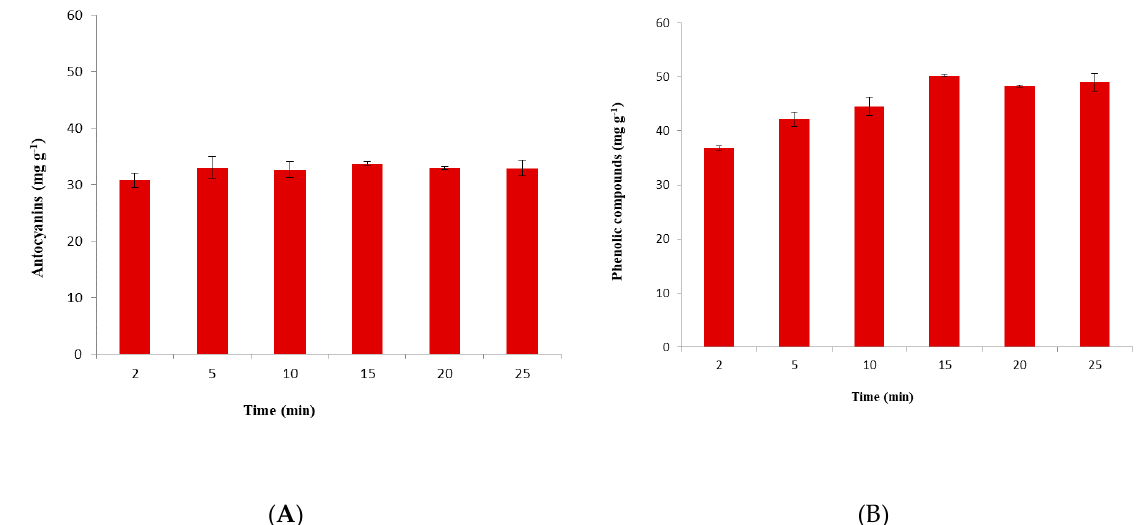
Figure 2. Effect of the extraction time on the recovery. ( A ) Total anthocyanins; and, ( B ) Total phenolic compounds.